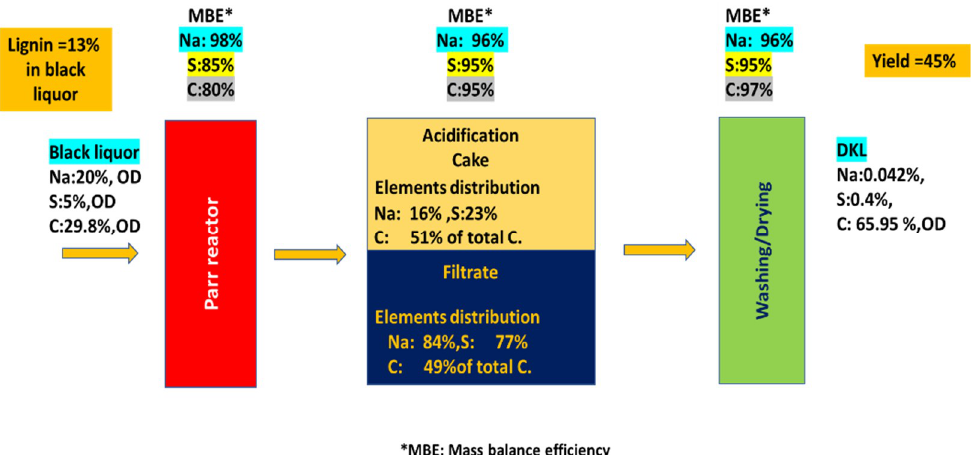
Figure 7. Schematic diagram illustrating the main unit operations of the DKL lignin recovery process (treatment of diluted KBL (with 9 wt. % KL) at 250 ◦ C for 2 h, with 5% of methanol co-solvent in the presence of NaOH/lignin ≈ 0.3 ( w / w )) along with the results obtained for elemental mass balance across all three unit operations.